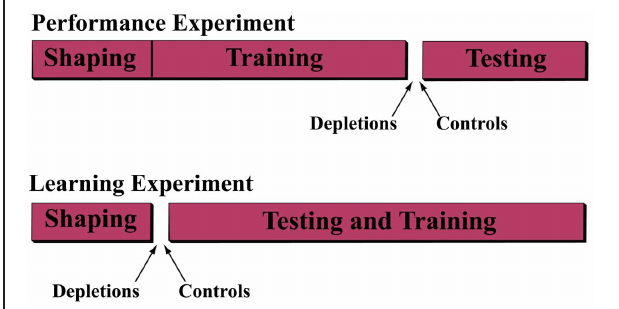
FIGURE 1 | Experimental scheme. In order to understand the role of acetylcholine in the ability to discriminate and to learn to discriminate temporally modulated stimuli, we performed two experiments. In the first ( performance experiment ) rats were trained on the discrimination task for 25 sessions, after which they were separated into either the cholinergic depletion (192 IgG-Saporin) or control (ACSF vehicle) group and re-assigned to the task for 7 sessions of testing. In the second experiment ( learning experiment ) the rats were assigned to the depletion or control group prior to administration of the discrimination task for 25